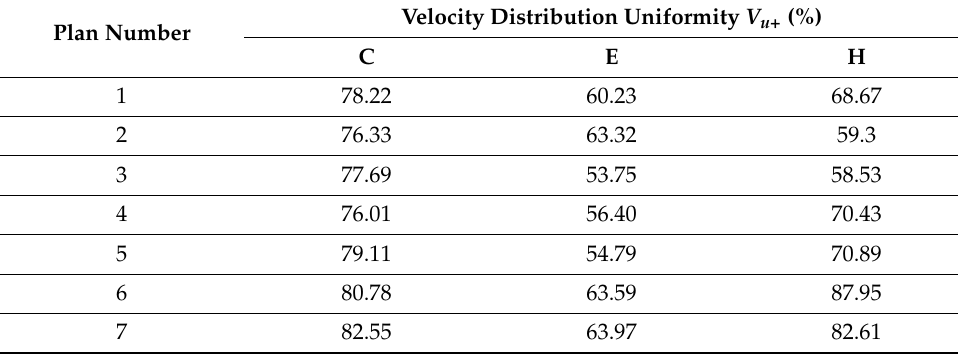
Table 4. Section velocity